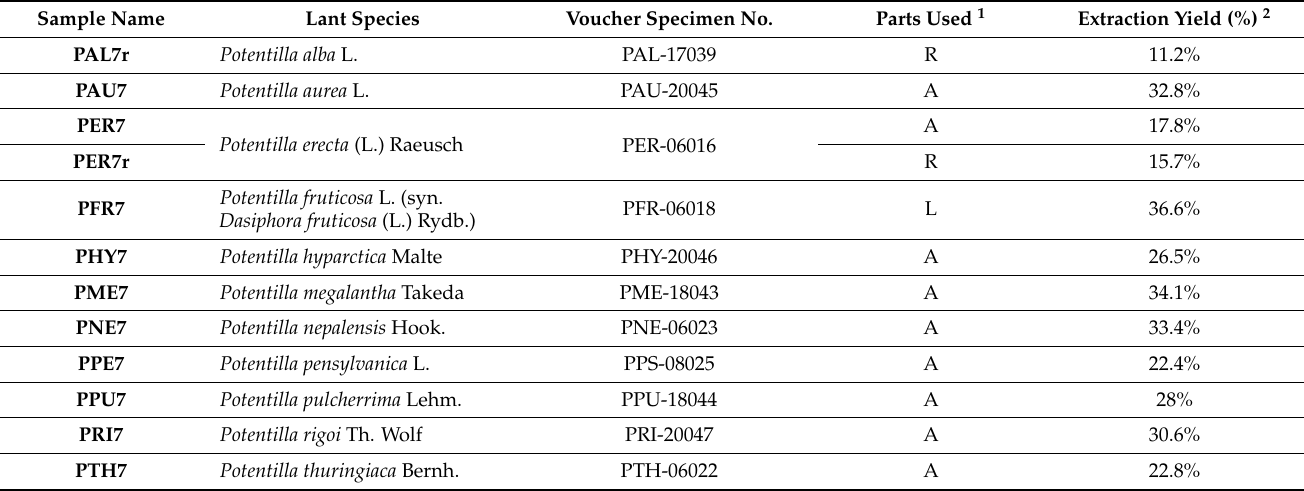
Table 4. List of plants from the Potentilla genus that were screened in the study and extraction